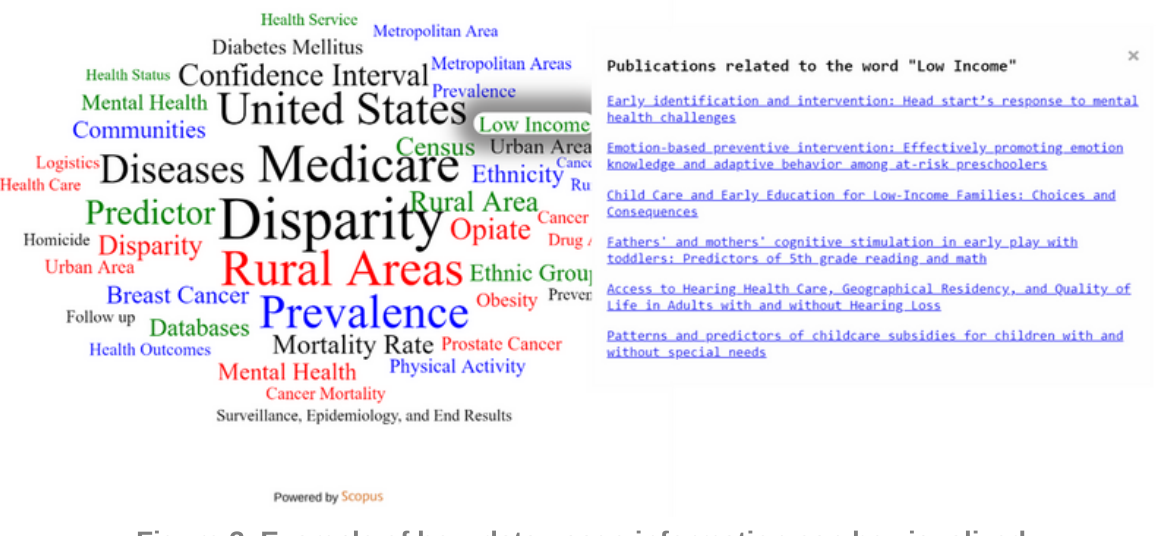
Figure 3. Example of how data usage information can be